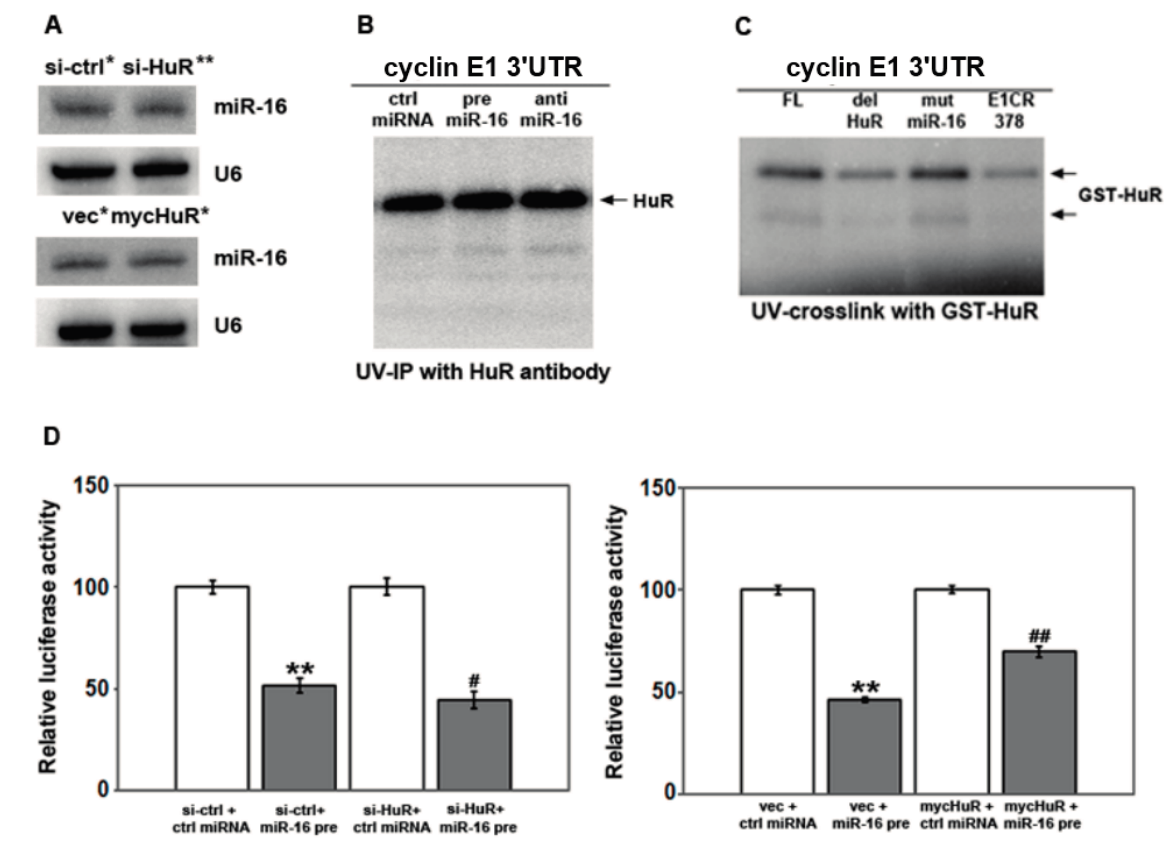
Figure 4. The affect of miR-16 on a reporter mRNA depends on HuR level. ( A ) MCF-7 cells were transfected with control siRNA or si-HuR, pcDNA3.1 vector or pcDNA3.1mycHuR for 48 h. miR-16 level was assessed by Northern blotting. The blots were reprobed with U6 snRNA as an internal control. Relative density was calculated relative to either si-ctrl or vec after normalization to U6 snRNA: * density = 1, ** density = 0.9; ( B ) 48 h after transfection of miR-16 precursor (pre miR-16) or antagomir (anti miR-16), the binding of HuR to the cyclin E1 3'UTR was detected by UV-crosslink immunoprecipitation. A representative experiment of three is shown; ( C ) UV-crosslink of GST-HuR with the full length cyclin E1 3'UTR (FL), the cyclin E1 3'UTR with the HuR binding sites deleted (del HuR) or the miR-16 sites deleted (mut miR-16), or the cyclin E1 coding region (E1CR378); ( D ) Cells were co-transfected with control miRNA or miR-16 precursor, pMIR-REPORT β -gal control vector or pMIR-REPORT luciferase vector containing either the cyclin E1 3'UTR 48 h after transfection with control siRNA or si-HuR, vector or pcDNA3.1mycHuR. Luciferase activity was measured using the Dual-Light System. The relative luciferase activity after normalization to pMIR-REPORT β -gal control plasmid is shown. The experiments were repeated three times. ** p < 0.01 versus si-ctrl or vec plus ctrl miRNA; # p < 0.05 versus si-ctrl plus miR-16 precursor; ## p < 0.01 versus vec plus miR-16